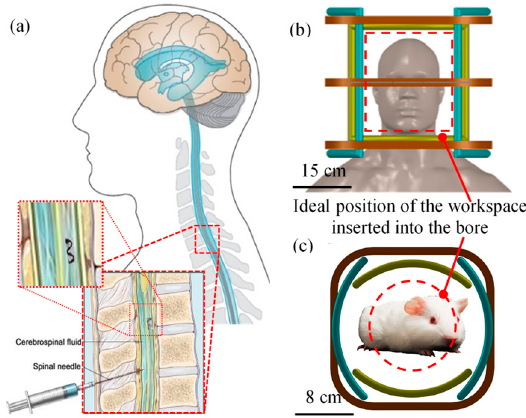
Figure 2. Schemes of biomedical applications by the HyBrid system. ( a ) A. deployment of a helical microswimmer to CSF by injection of a spinal needle, then swim to access brain. ( b ) Magnetic manipulation in a human head inserted into the bore space of the system about r 12 × 30 cm 3 . ( c ) An in vivo experiment in a 12-cm-sized mouse inserted into the bore space of the system about r 7.5 × 18 cm 3 .